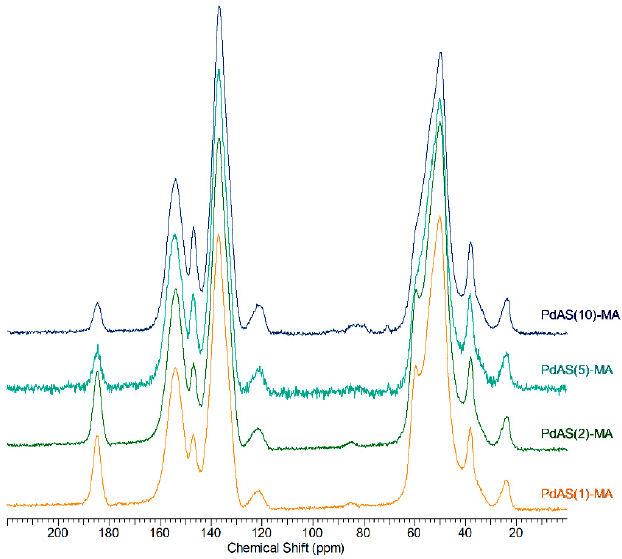
Figure 4. CP/MAS 13 C NMR spectra of PdAS(x)-MA catalysts.